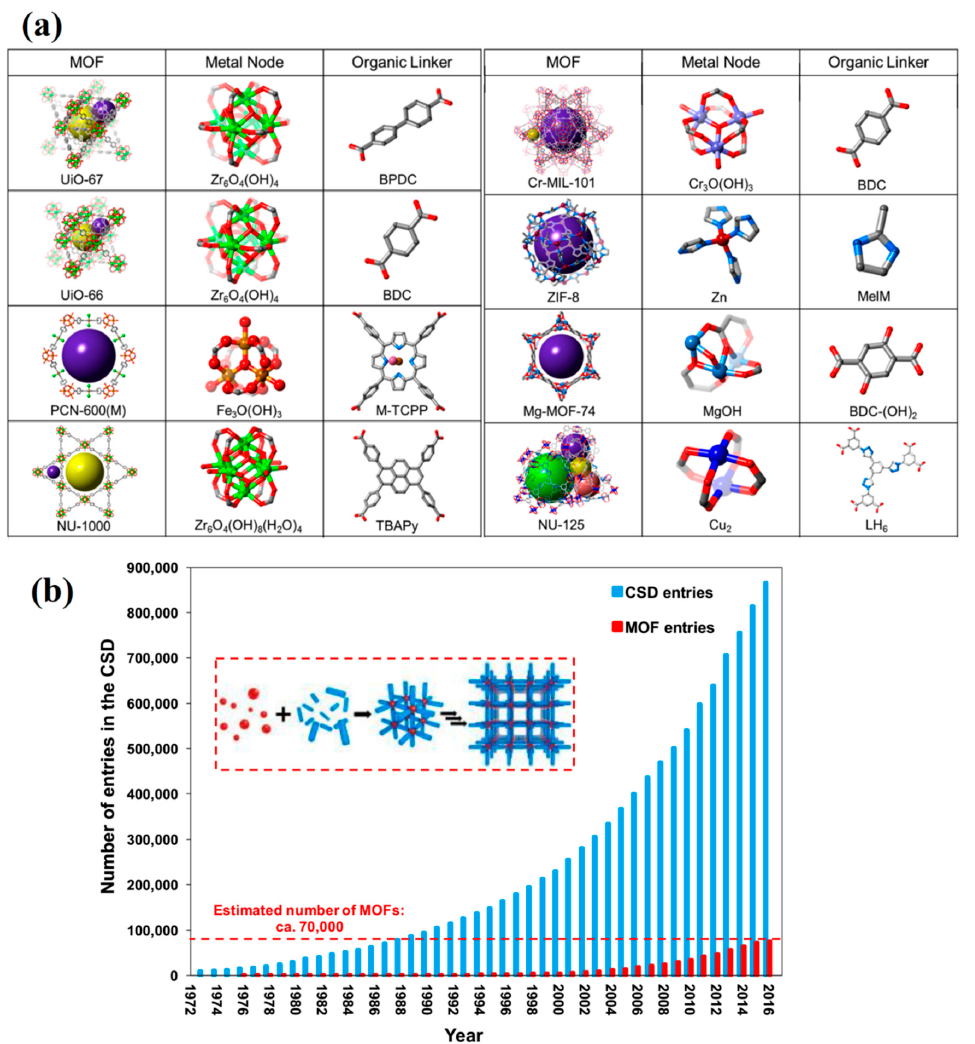
Figure 1. Metal-organic framework (MOF); ( a ) combination of building blocks of MOF, with different types of metal atoms as the nodes and various kinds of carboxylic ligands as the organic linkers, used in the fabrication of exquisite structures [39] , ( b ) The number of different kinds of fabricated MOF structures (Source: The Cambridge Structural Database (CSD)) [64] revealing that more than 70,000 different structures of MOFs have been introduced prior to 2016. The exponential trend in the number of publications released in the last decade extracted from the Scopus database (based on the keywords of “metal-organic framework” and “MOF”) can be